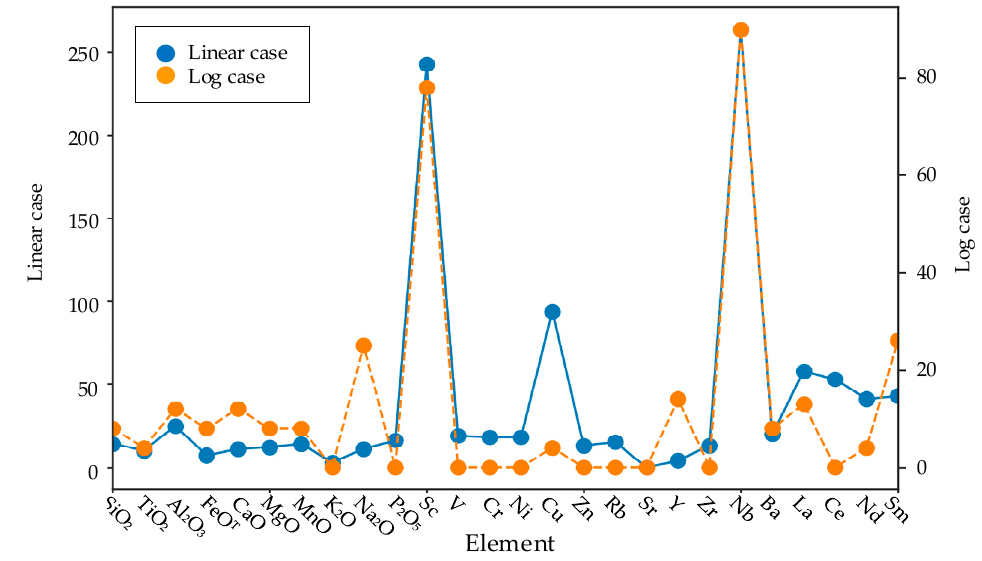
Figure 16. Statistics of the frequency of occurrence of the 26 basic elements in useful OIG and non- OIG discrimination diagrams.